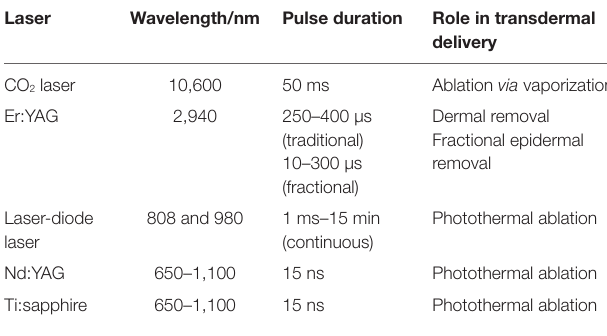
TAble 2 | Lasers used for transdermal drug delivery via skin